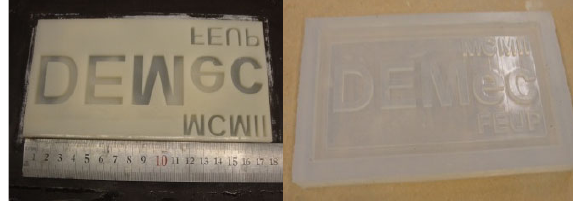
Figure 9. Stereolithography model and silicon mould.